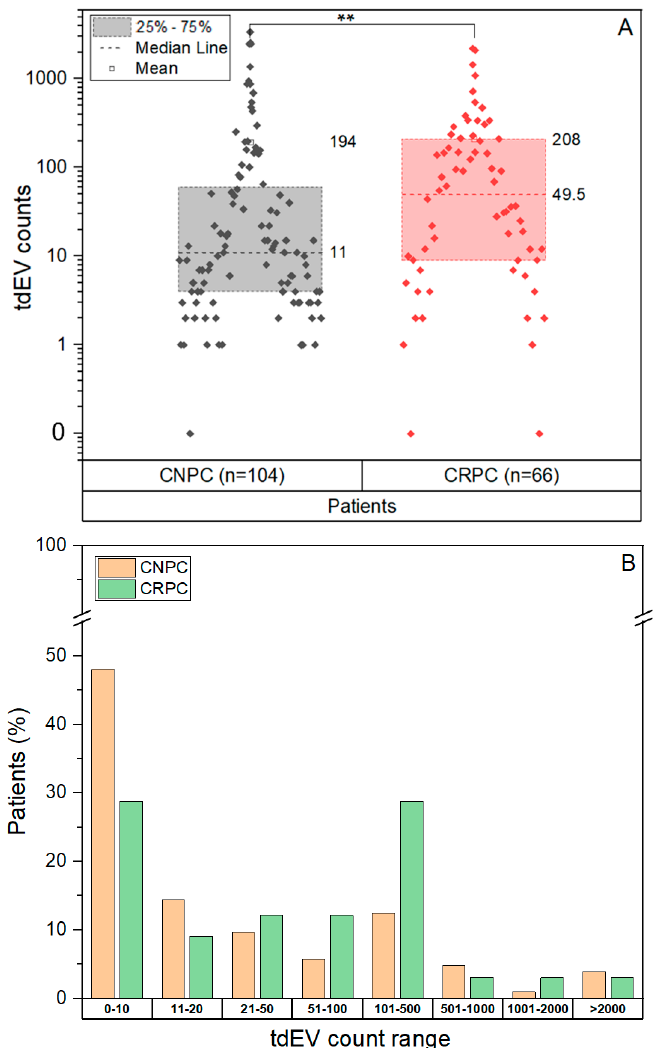
Figure 4. Presence of tdEVs in CNPC and CRPC before initiation of therapy. ( A ): The tdEV counts obtained from CNPC and CRPC patients were tested to check for differences between the patient cohorts. tdEVs showed a significant difference ( p = 0.005) between CNPC (mean rank = 77.05, median = 11) and CRPC (mean rank = 98.81, median = 49.5). ( B ): The percentage of patients sorted on increasing tdEVs in CNPC and CRPC. ** Significance p < 0.01.